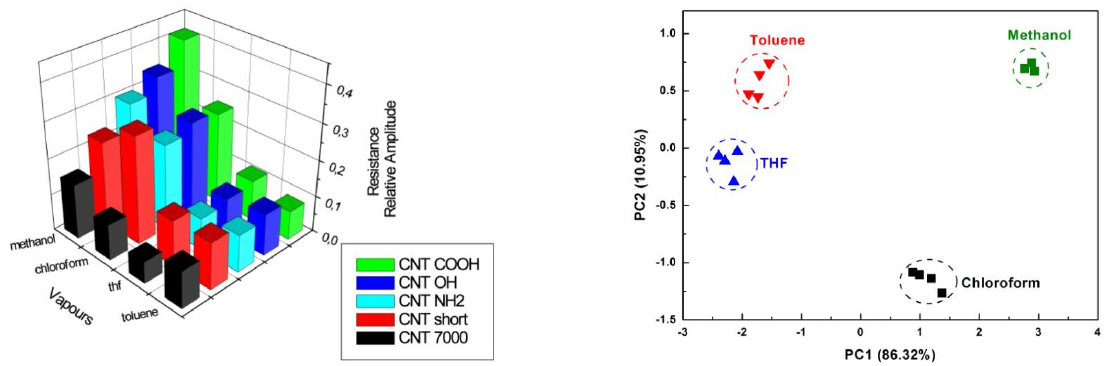
Figure 6. Selectivity of CNT sensors towards methanol, chloroform, THF and toluene expressed directly in bar graph ( left ) and after Principal Component Analysis (PCA) treatment of the data from an e-nose ( right ).